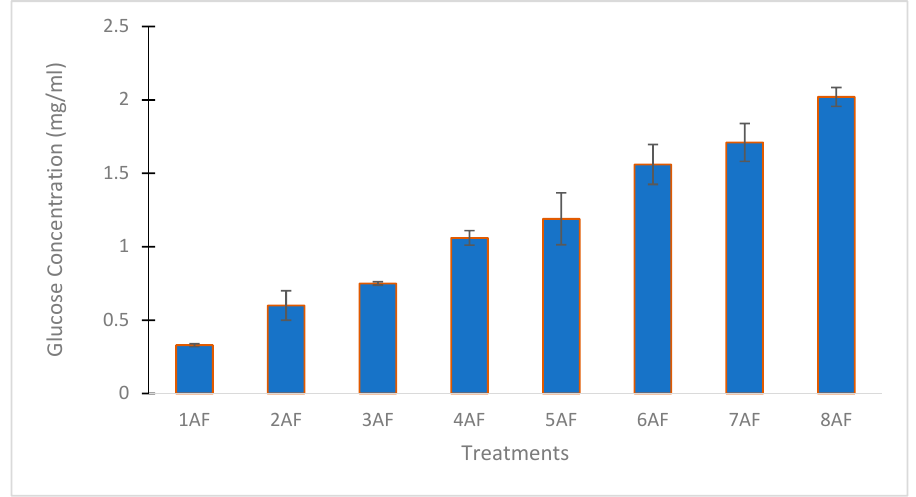
Figure 3. Determination of the optimum HCl concentration that would result in the production of the highest glucose concentration liberated from cellulosic fiber wastes after autoclaving treatment.